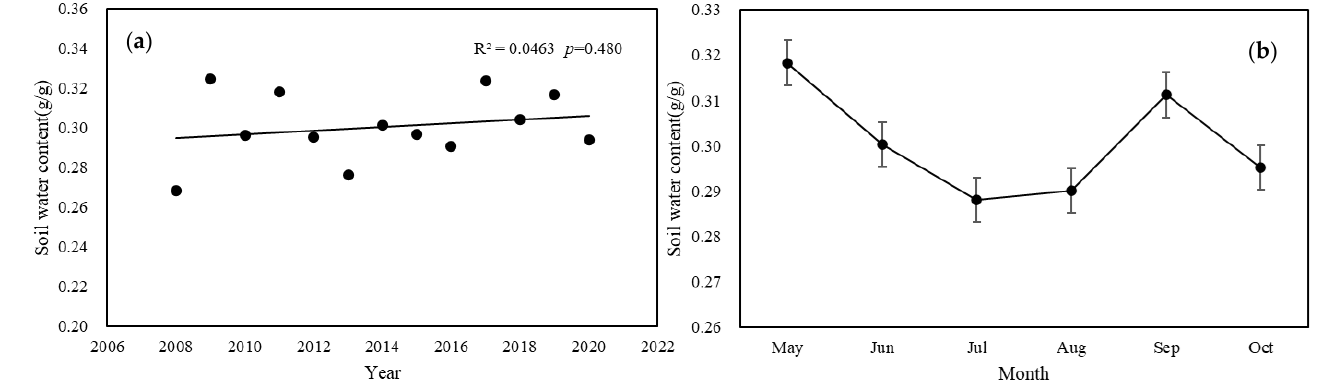
Figure 3. Inter- and intra-annual variation of soil water content. ( a ) Indicates interannual variation of soil water content, and ( b ) indicates months’ variation of soil water content in growth season.